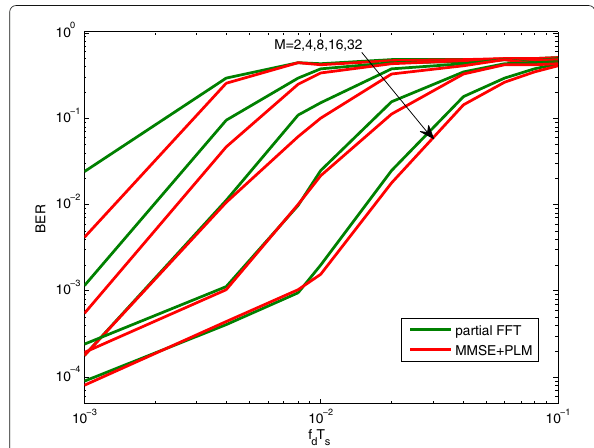
Fig. 6 BER performance against normalized Doppler frequencies, N s = 512, SNR = 30 dB